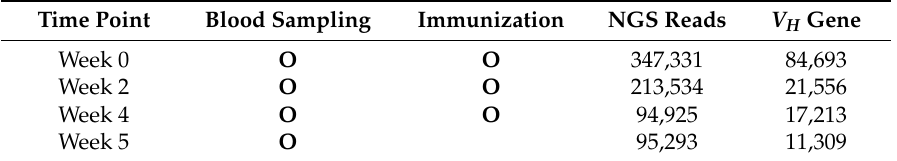
Table 1. Blood sampling, next-generation sequencing (NGS) analysis, and